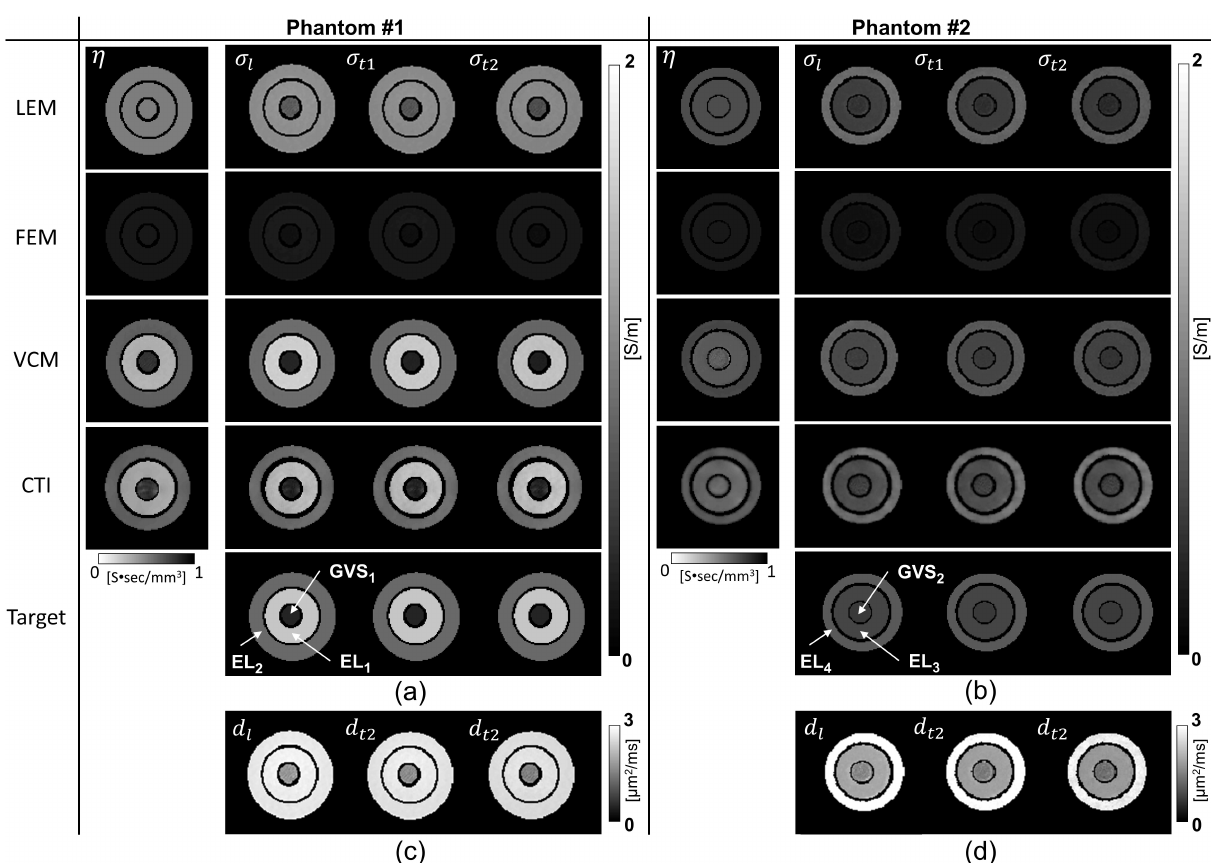
Figure 1. Reconstructed conductivity tensor images of phantoms #1 ( a ) and #2 ( b ). Target images are the true conductivity tensor images generated using the conductivity values measured by the impedance analyzer. ( c , d ) are the diffusion tensor images of phantoms #1 and #2, respectively. The VFM method was not applicable to the phantoms since it was specifically designed for the brain tissues.